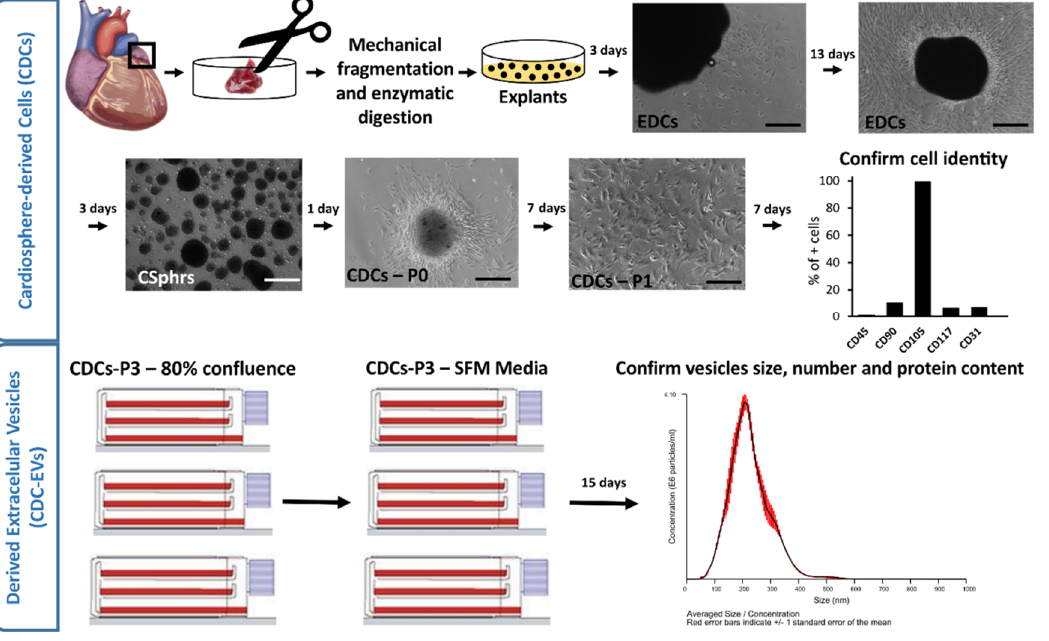
Figure 1. Methodology employed for cardiosphere-derived cell extracellular vesicle (CDC-EV) isolation. Scale bars correspond to 200 µm. Cardiac biopsies from patients were immediately processed through mechanical and enzymatic digestion to obtain explants of 1–2 mm. Explant-derived cells (EDCs) started leaving the explant and colonizing the plate after approximately 48 h of culture and reached full confluency after approximately 16 days. Then, the cells were transferred to ultra-low-attachment plates for 72 h to allow them to form three-dimensional (3D) spheroids (cardiospheres). Cardiospheres were passaged to produce the so-called cardiosphere-derived cells (CDCs-P0). Cell identity was confirmed by flow cytometry in CDCs-P1 cells, with 0.9% CD45 + cells, 10.6% CD90 + cells, 6.6% CD117 + cells, 99.8% CD105 + cells, and 7.4% CD31 + cells. CDCs were further passaged until CDCs-P3 reached 80% confluence. At that point, the medium was changed to FBS-free IMDM and left unchanged for 15 days to allow CDCs to secrete and concentrate EVs in the medium. Conditioned medium was filtrated and ultraconcentrated, and EVs were precipitated and further resuspended. Quantification was performed through nanoparticle tracking analysis (NTA). The average particle size was 200 µ m and the maximum particle size was 450 µ